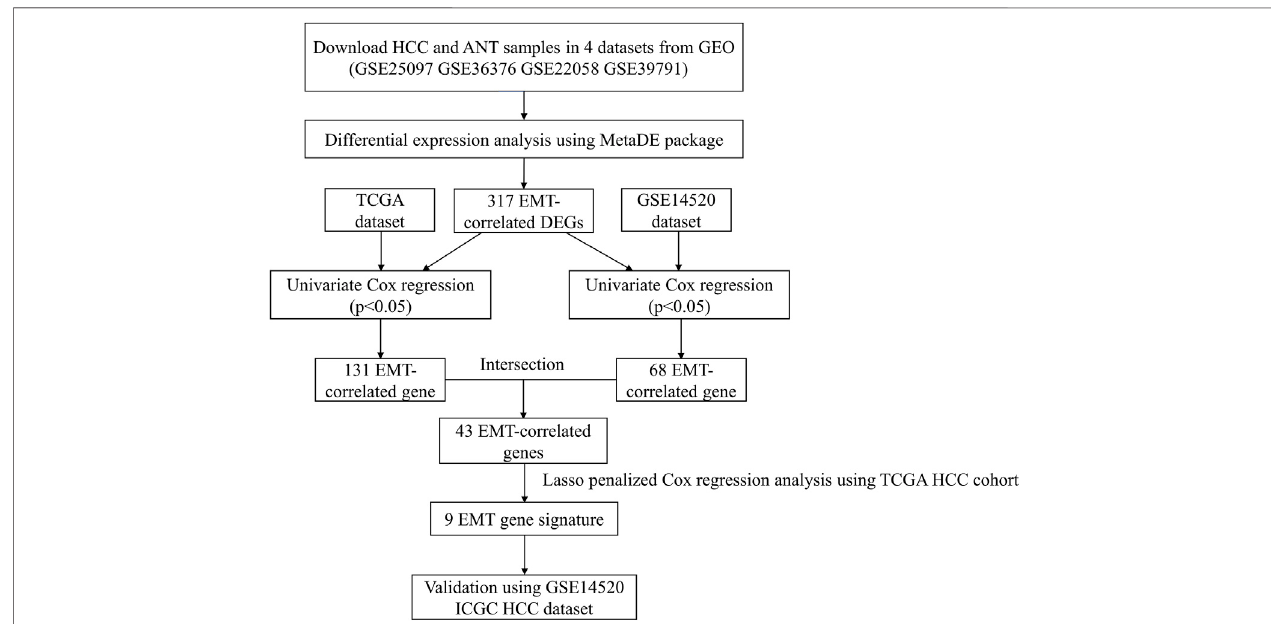
FIGURE 1 | The work fl ow of this